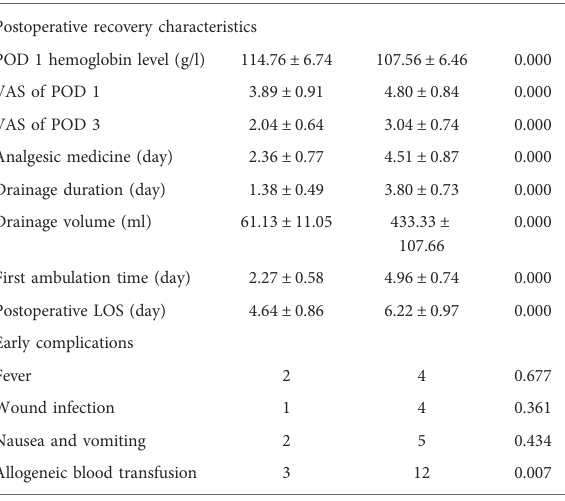
4 Postoperative recovery characteristics and early complications of two